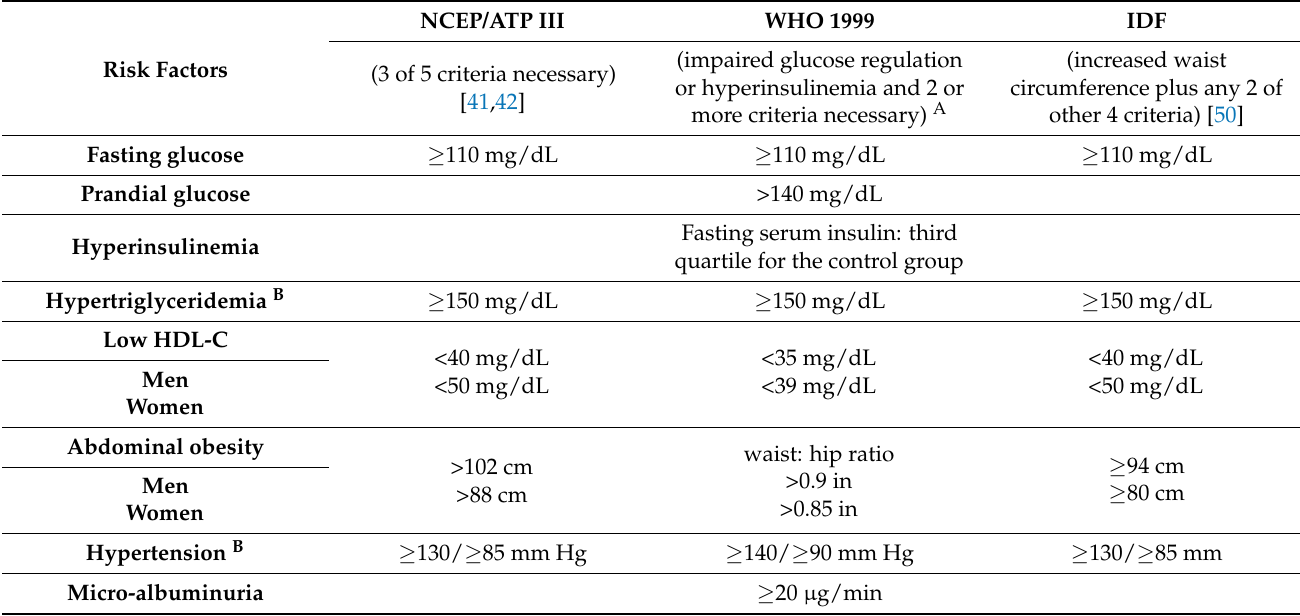
A World Health Organization. Definition, diagnosis, and classification of diabetes mellitus and its complications: report of a WHO consultation. Part 1: diagnosis and classification of diabetes mellitus. Geneva, Switzerland: World Health Organization, 1999. B Considered positive criteria if a person is on medications for lipids, hypertension, or hyperglycemia regardless of value. Abbreviations: NCEP/ATP III, National Cholesterol Education Program/Adult Treatment Panel III; WHO, World Health Organization; IDF, International Diabetes Federation; HDL, high-density